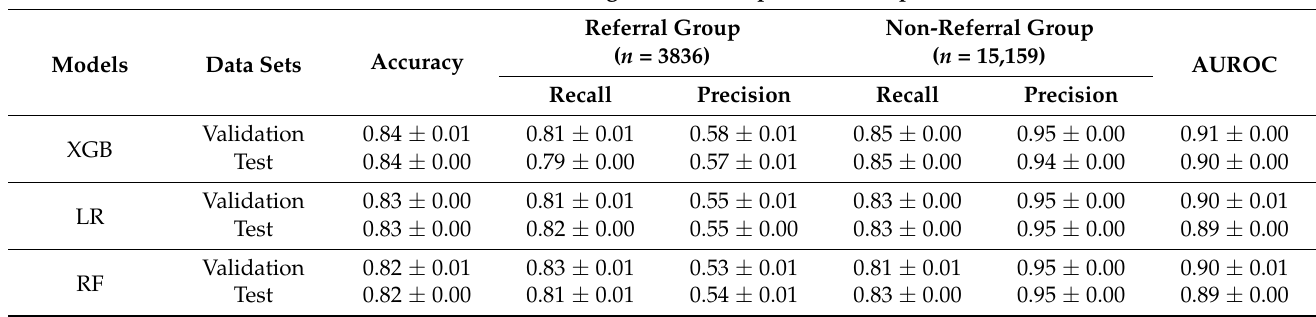
Table 5. Cont. Loose Inclusion and Labeling Criteria Compared with Experiment